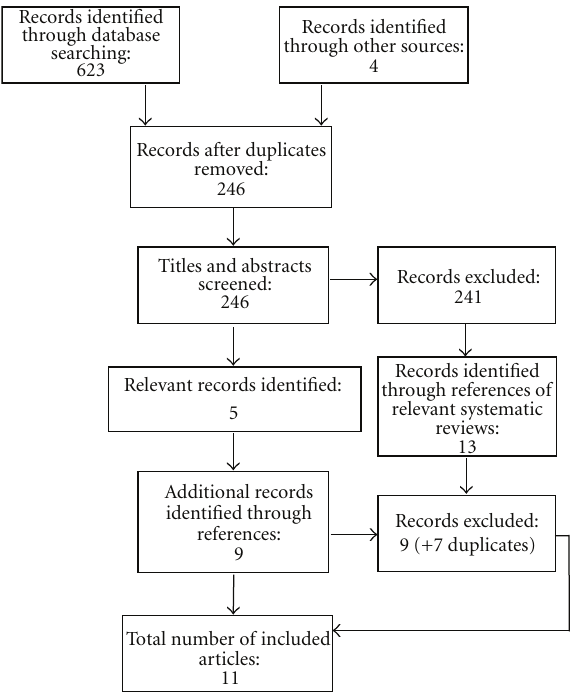
Figure 1: Flowchart of review process. Note: flowchart based on PRISMA flow diagram [14] with